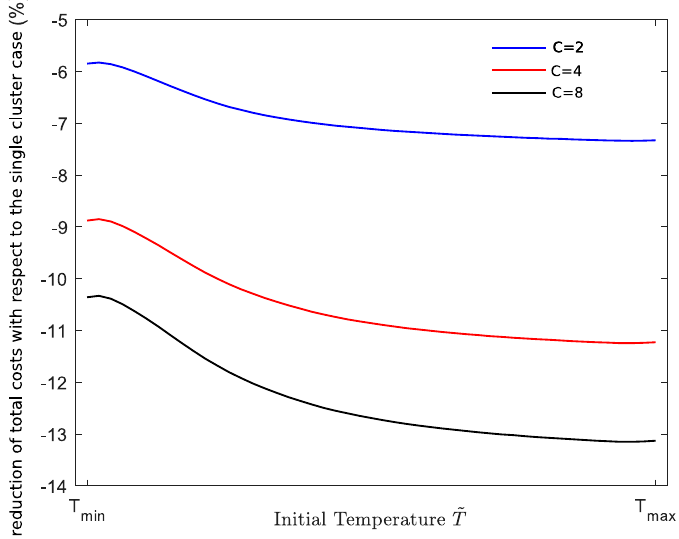
Figure 9. Percent reduction in total costs for individual TCLs when the TCL population in partitioned in C = 2 (blue), C = 4 (red), and C = 8 (black) clusters with respect to the case when C = 1.